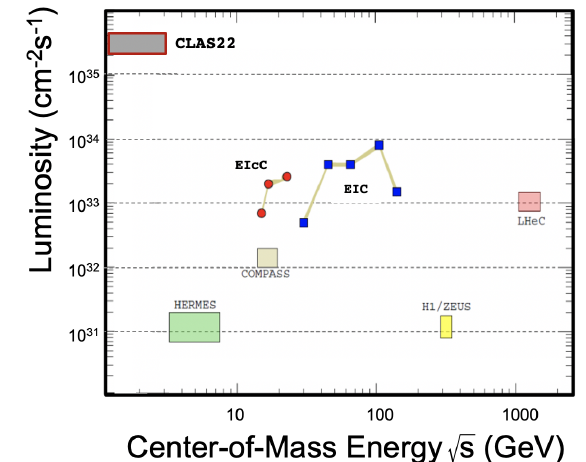
Figure 11. Luminosity versus CM energy in lepton–proton collisions for existing and foreseeable facilities capable of exploring hadron structure in measurements with large-acceptance